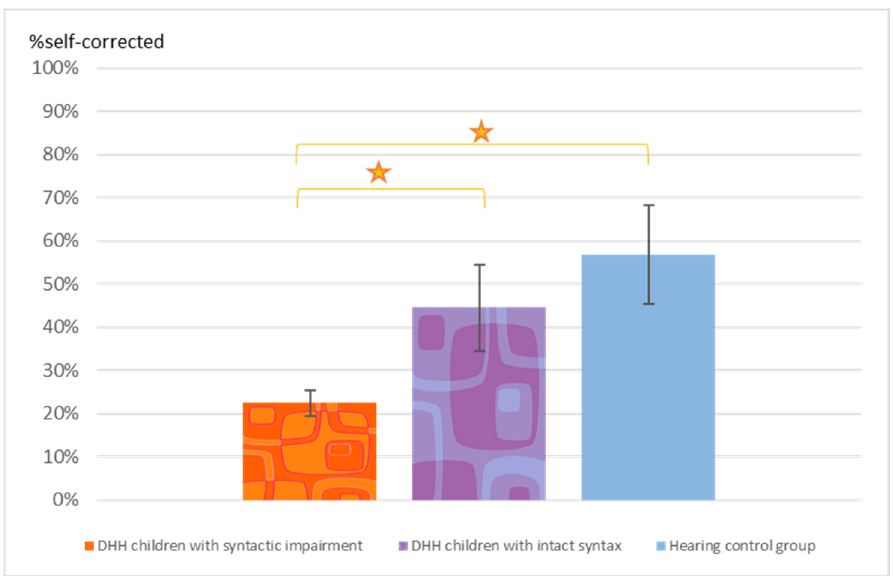
Figure 2. Percentage self-corrections of reading errors in the texts with movement. Star: p < 0.0001.